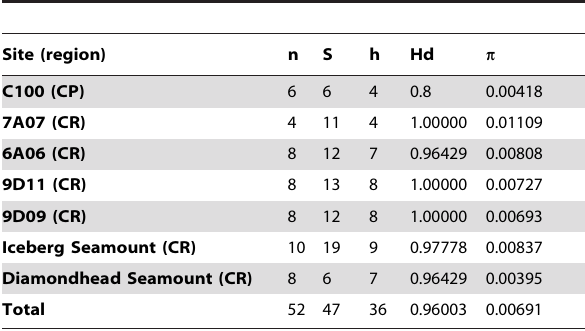
Table 2. Intra-population mt COI diversity statistics for the squat lobster, Munida gracilis .